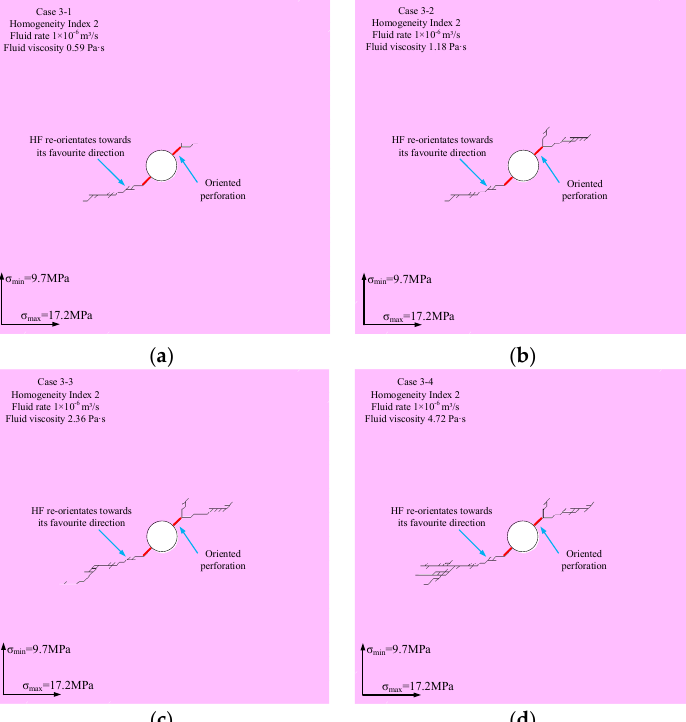
Figure 9. The relationship between HF re-orientation and fluid viscosity when the homogeneity index is equal to 2: ( a ) fluid viscosity is 0.59 Pa·s; ( b ) fluid viscosity is 1.18 Pa·s; ( c ) fluid viscosity is 2.36 Pa·s; ( d ) fluid viscosity is 4.72 Pa·s.